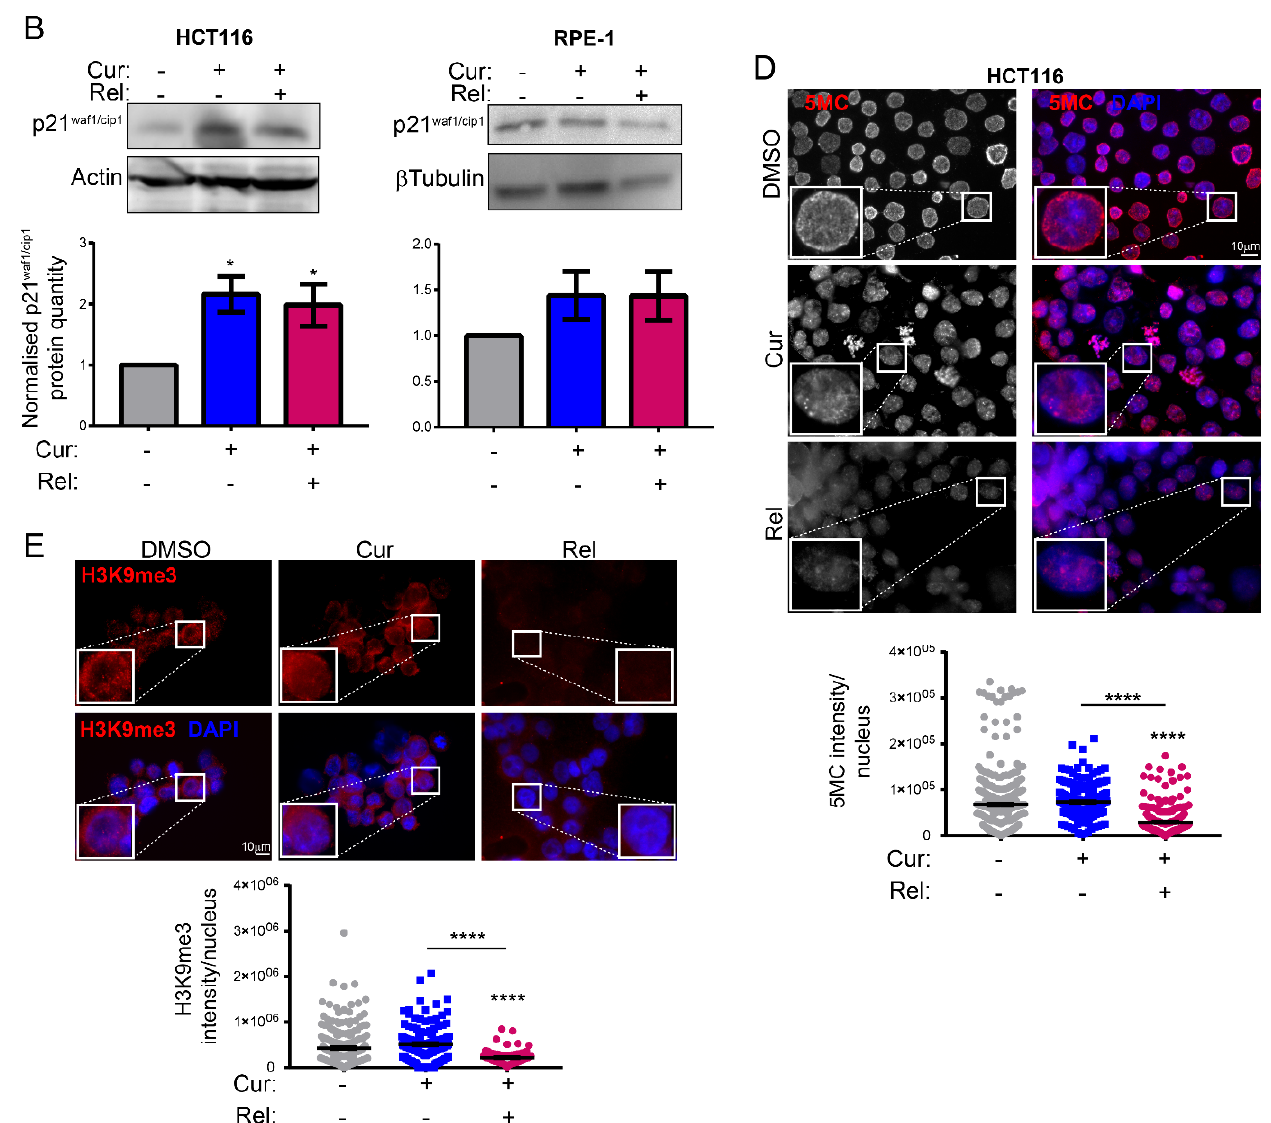
Figure 3. Curcumin-induced senescence correlates with p21 activation and global reduction in heterochromatin markers: ( A ) Histograms showing the expression of the p21 gene in HCT116/RPE-1 Cur and Rel cells relative to control. n = 3. Un-paired t -test: *** p < 0.001, ** p < 0.01; ( B ) immunoblots of cell extracts with antibodies against p21. Antibodies against β -tubulin or actin are used as a loading control. Graphs summarizing the quantification of three independent experiments. Un-paired t -test: * p < 0.05; ( C ) representative DAPI-staining images of senescent IMR90 cells and HCT116 Rel cells. SAHF are visible only in senescent IMR90 nuclei, which are used as a control. n = 2. Scale bar = 10 µm; ( D ) representative immunofluorescence images showing the pattern of 5-methyl-cytosine (5MC) antibodies in HCT116 cells with the indicated treatment. Scale bar = 10 µm. Graph showing the global reduction in 5MC in HCT116 Rel cells. n = 3. Un-paired t-test: **** p < 0.0001; ( E ) representative immunofluorescence images showing the pattern of H3K9me3 antibodies in HCT116 cells with the indicated treatment. Scale bar = 10 µm. Graph showing the global reduction in H3K9me3 in HCT116 Rel cells. n = 3. Un-paired t-test: **** p < 0.0001.